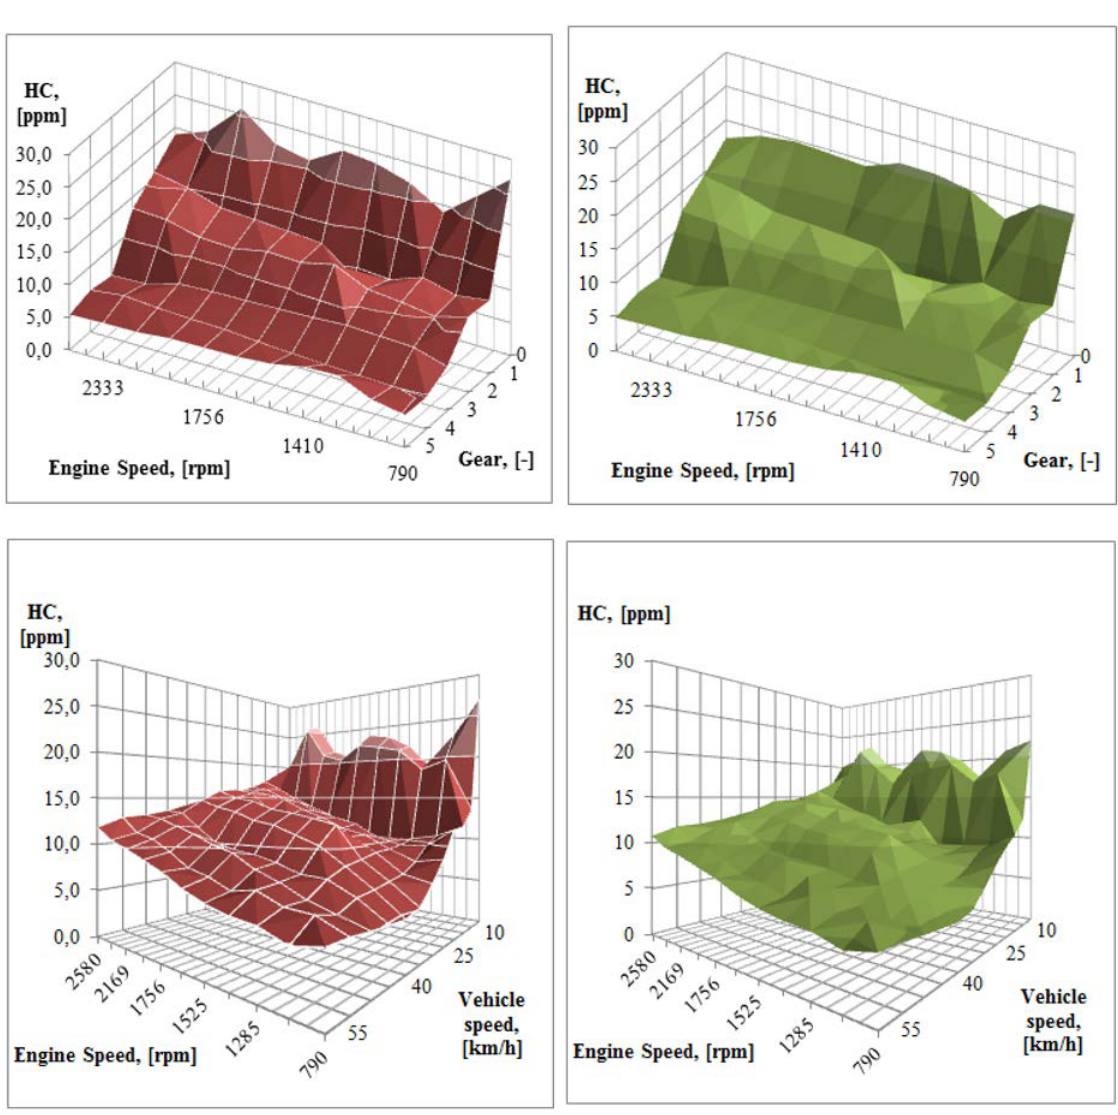
Figure 13. Hydrocarbons emissions. a. HC versus engine speed for different gear ratios in standard operating conditions; b. HC versus engine speed for different gear ratios with IAP operation; c. HC versus engine speed for different vehicle speeds in standard operation; d. HC versus engine speed for different vehicle speeds with IAP